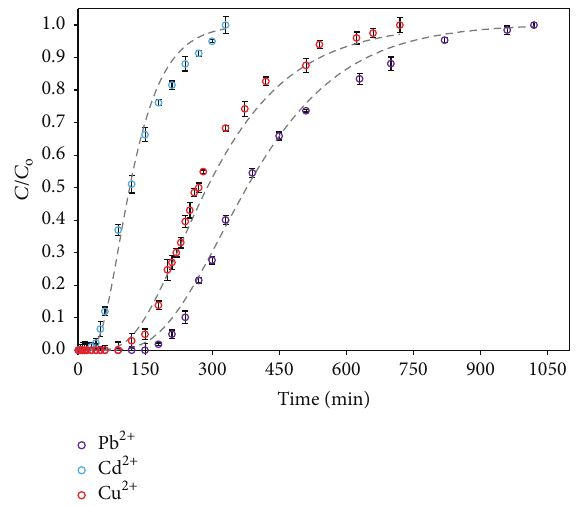
Figure 8: Mass transfer model for heavy metal adsorption onto SCG. Experimental conditions: 0.1 mM initial metal concentration, 14cm bed height, 5.5 flow rate, and 25 ∘ C. Dashed lines represent the mass transfer